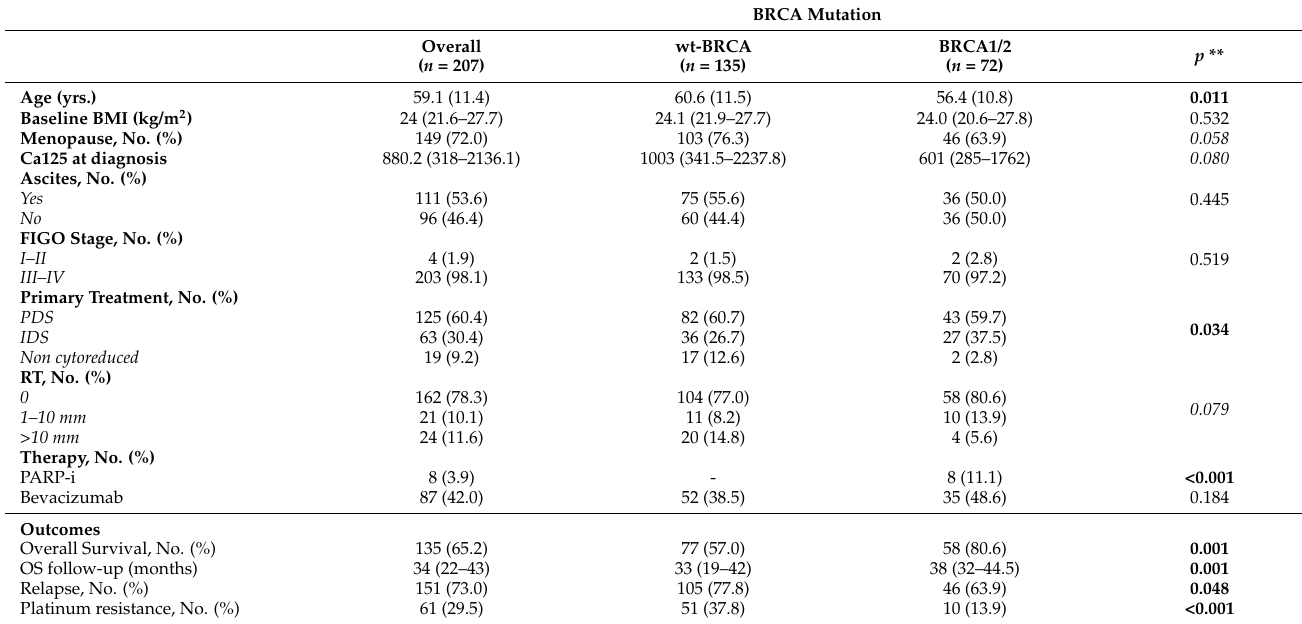
Table 1. General characteristics of the study sample according to BRCA-wt and